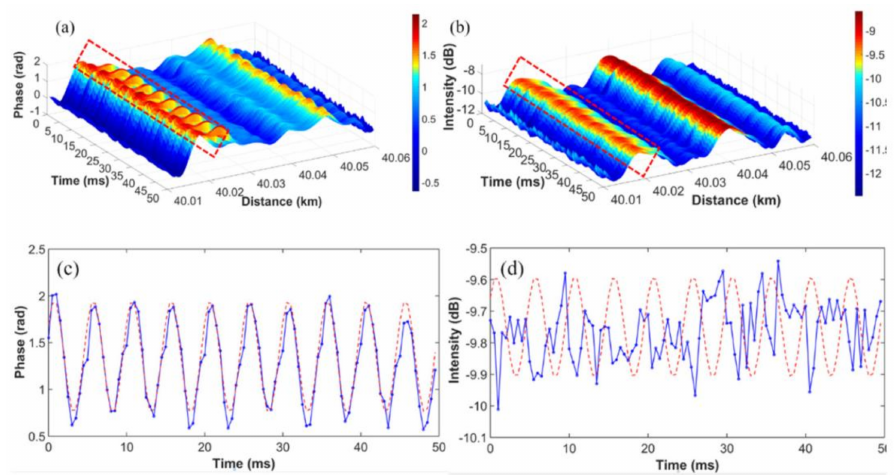
Figure 24. Experimental results of DVOFS based on TGD-OFDR with a 200 Hz sinusoidal excitation at z = 40.02 km. ( a ) Distance-time mapping trace of the phase term of Rayleigh backscattering. ( b ) Distance-time mapping trace of the intensity term of Rayleigh backscattering. ( c ) Phase-time curve of a vibration event. ( d ) Extracted intensity-time curve of a vibration event (reprinted from Wang et al. [56] with permission of OSA; copyright (2015)).